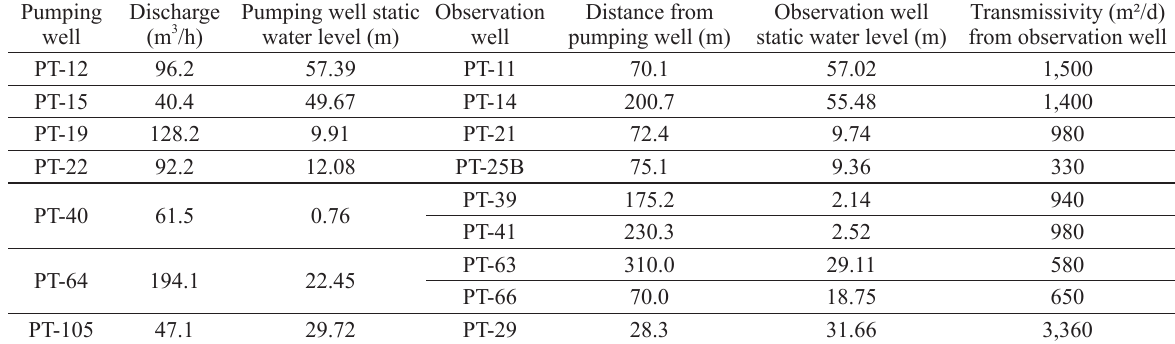
information about seven long duration (48 h) transient pumping tests conducted in the SAAE’s supply wells. All the tests were pumping water from the Sete Lagoas Karst